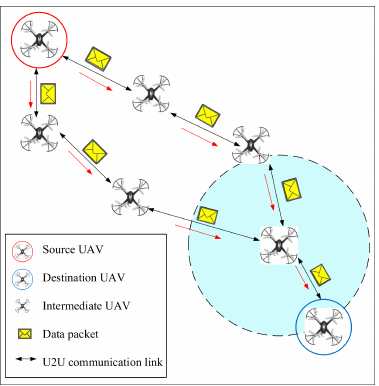
Figure 14. Multi-path routing. Table 3. Comparison of single and multiple